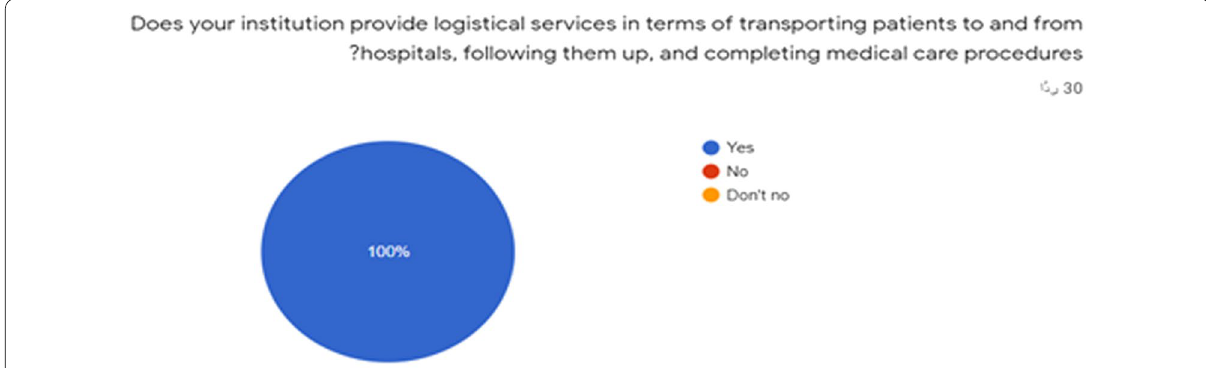
Fig. 2 Opinions about the provision of logistical services